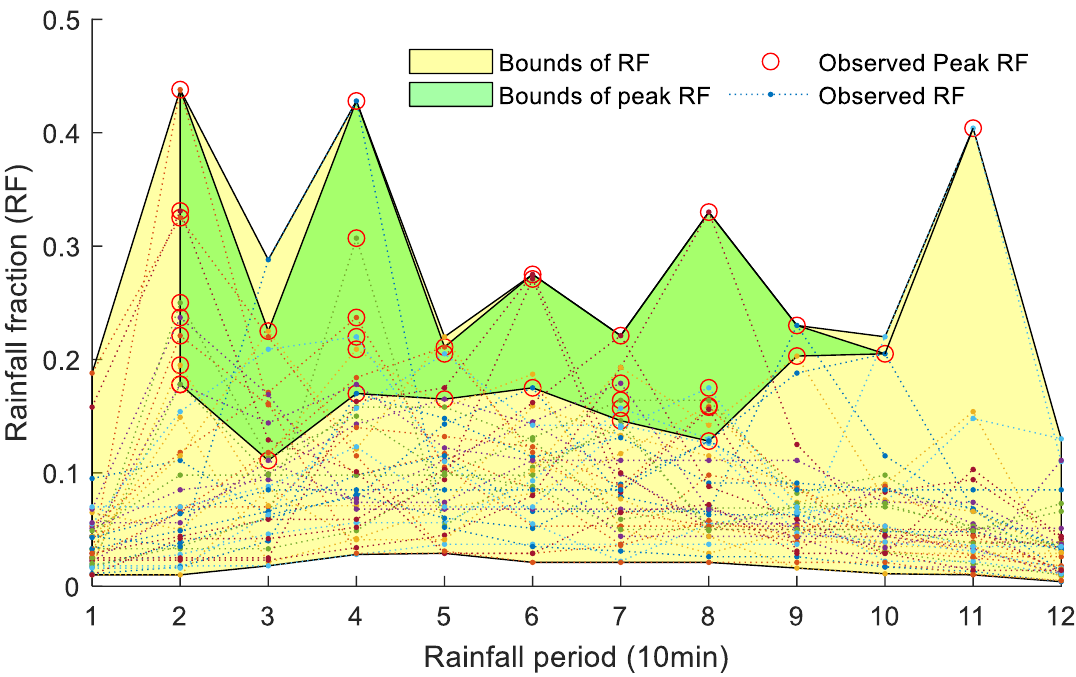
Figure 3. Rainfall fractions (RF) of 12 periods and their upper and lower limits. For a period, the upper (lower) limit of RF equals the maximum (minimum) value of the measured RFs. For a period, the upper (lower) limit of peak RF means is the maximum (minimum) value of the measured RFs of precipitation events that peaked in that period. The points with different colors represent the fractions of observed rainfalls.